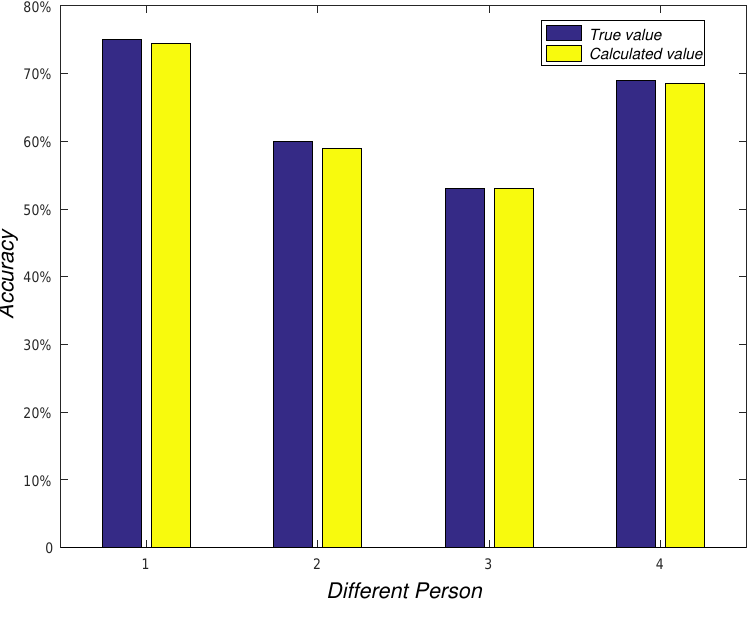
Figure 7. Calculating stride-length performance.